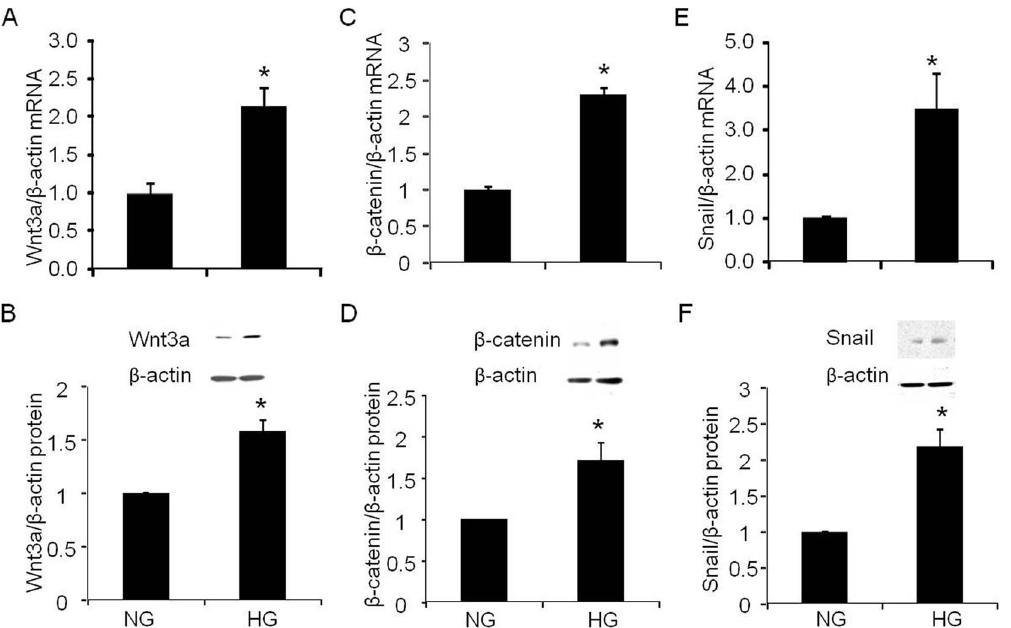
Figure 4. Effect of high glucose on Wnt3a- b -catenin-snail signal pathway in podocytes. A. Real time PCR analysis of Wnt3a mRNA expression (n=5); B. Western blot analysis of Wnt3a protein expression (n=4); C. Real time PCR analysis of b -catenin mRNA expression (n=6); D. Western blot analysis of b -catenin mRNA expression (n=5); E. Real time PCR analysis of snail mRNA expression (n=5); F. Western blot analysis of snail protein expression (n=4); Normal glucose, 5 mM D-glucose (NG); high glucose, 25 mM D-glucose (HG). Data presented as mean 6 SEM, * p , 0.05 vs NG